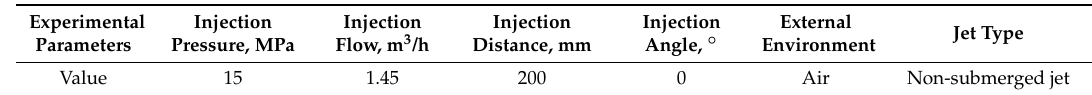
Table 9. The experimental parameters.